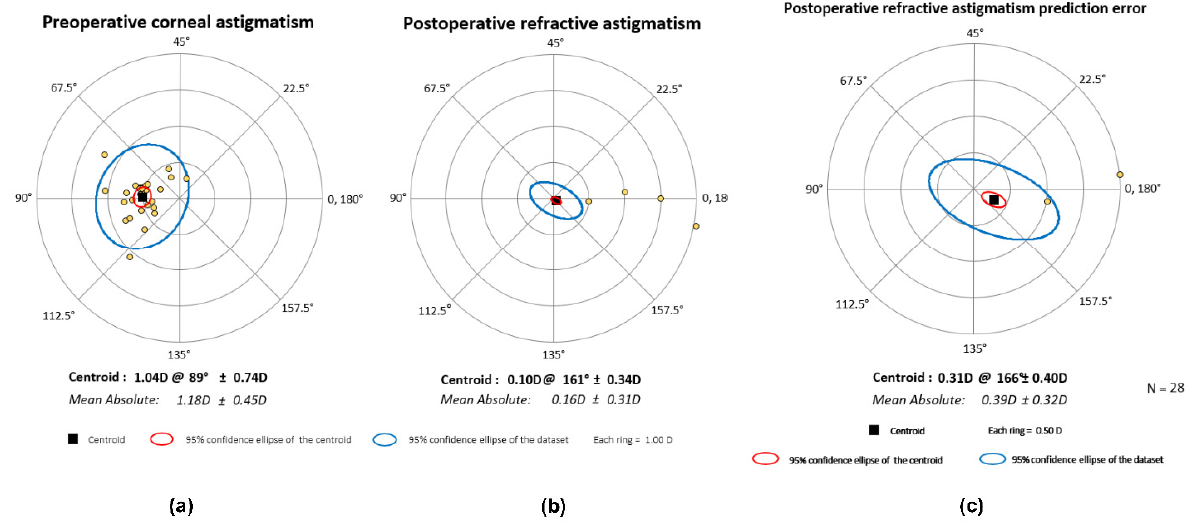
Figure 3. Double-angle plots of preoperative ( a ) and refractive astigmatism ( b ) and of the prediction error ( c ) measured and calculated one year after surgery.